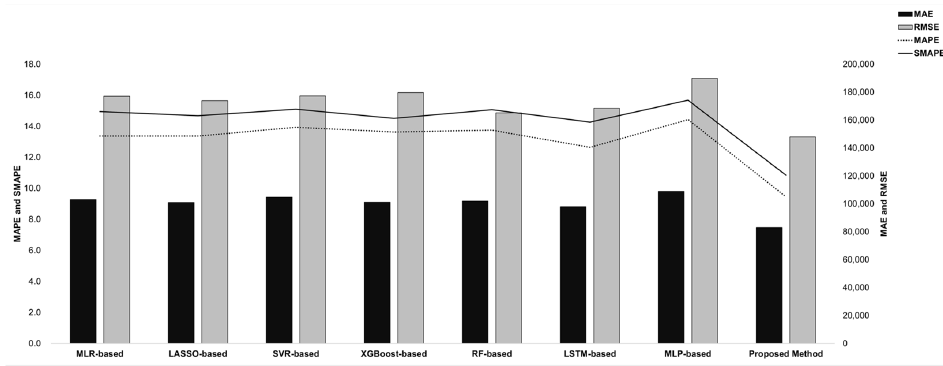
Figure 7. Average performance of compared methods on 25 mail center datasets.